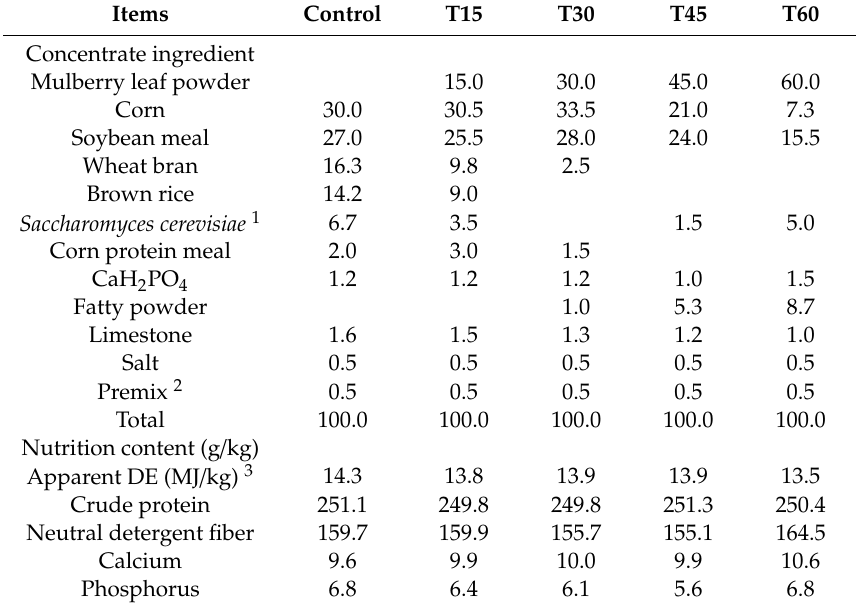
Table 1. Concentrate composition and nutrition content of diets to fattening Hu sheep (on the DM basis)